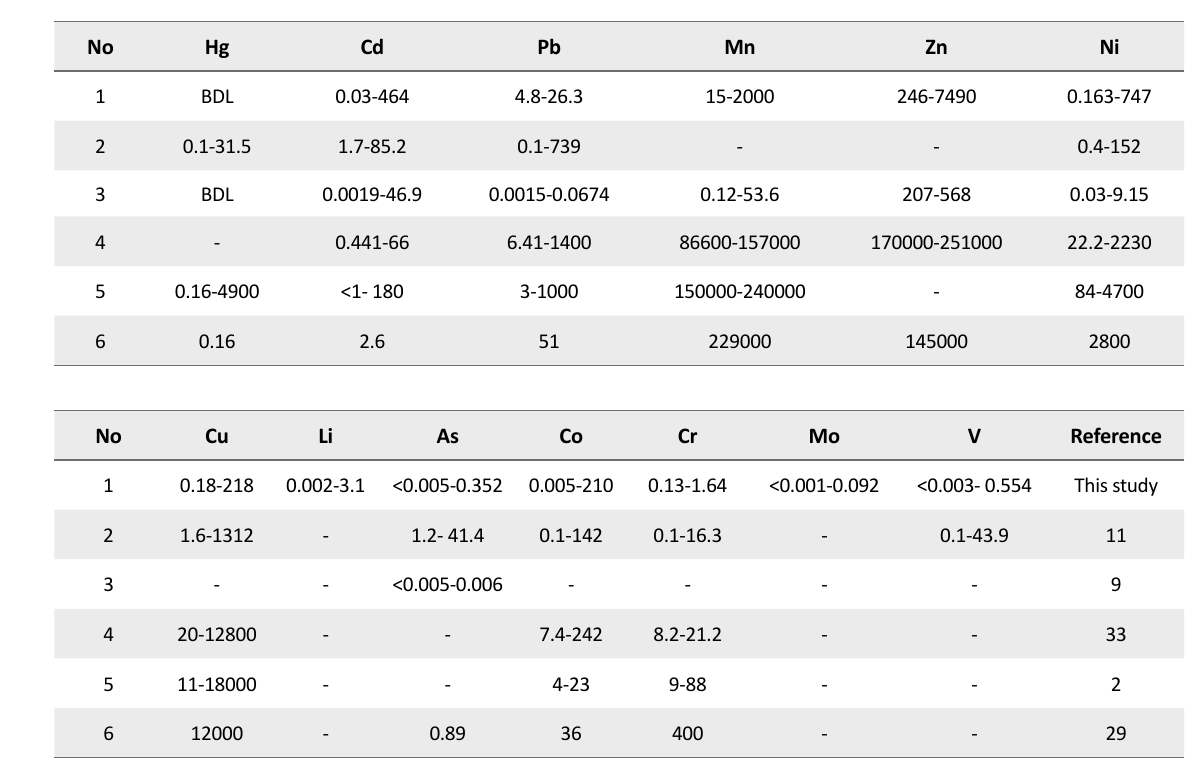
Table S1. Comparison of heavy metal contents with other studies (mg